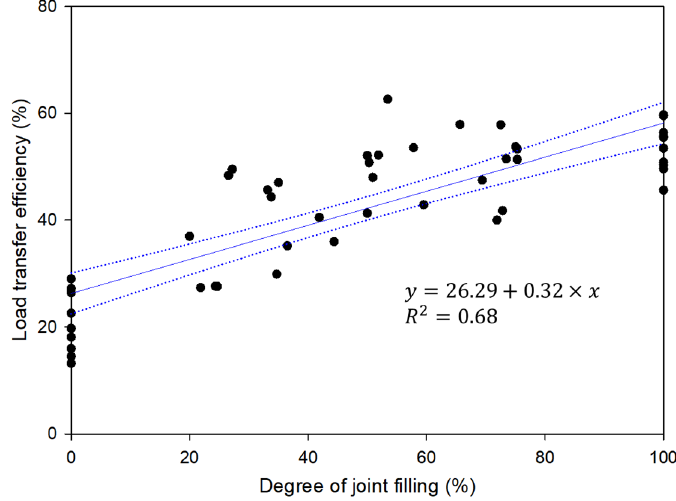
Figure 8. LTE according to the degree of joint filling.